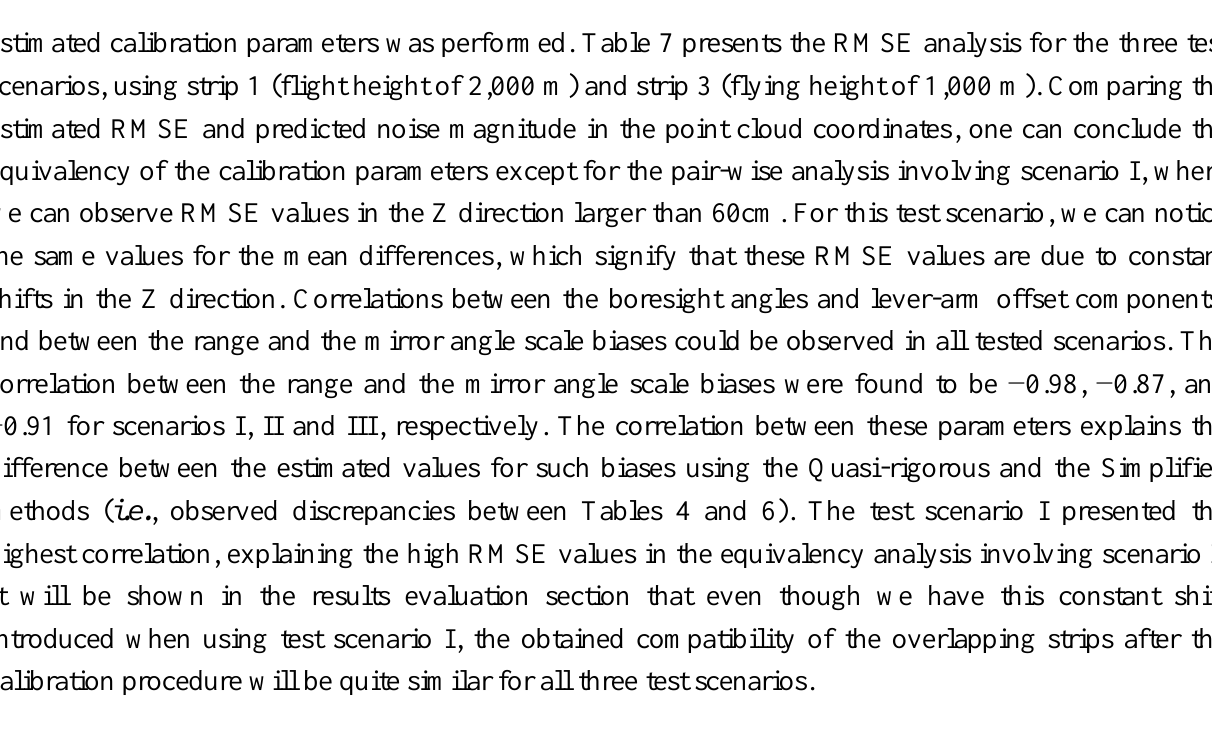
Table 6. Estimated system biases using the Quasi-rigorous method for the 3 test scenarios.